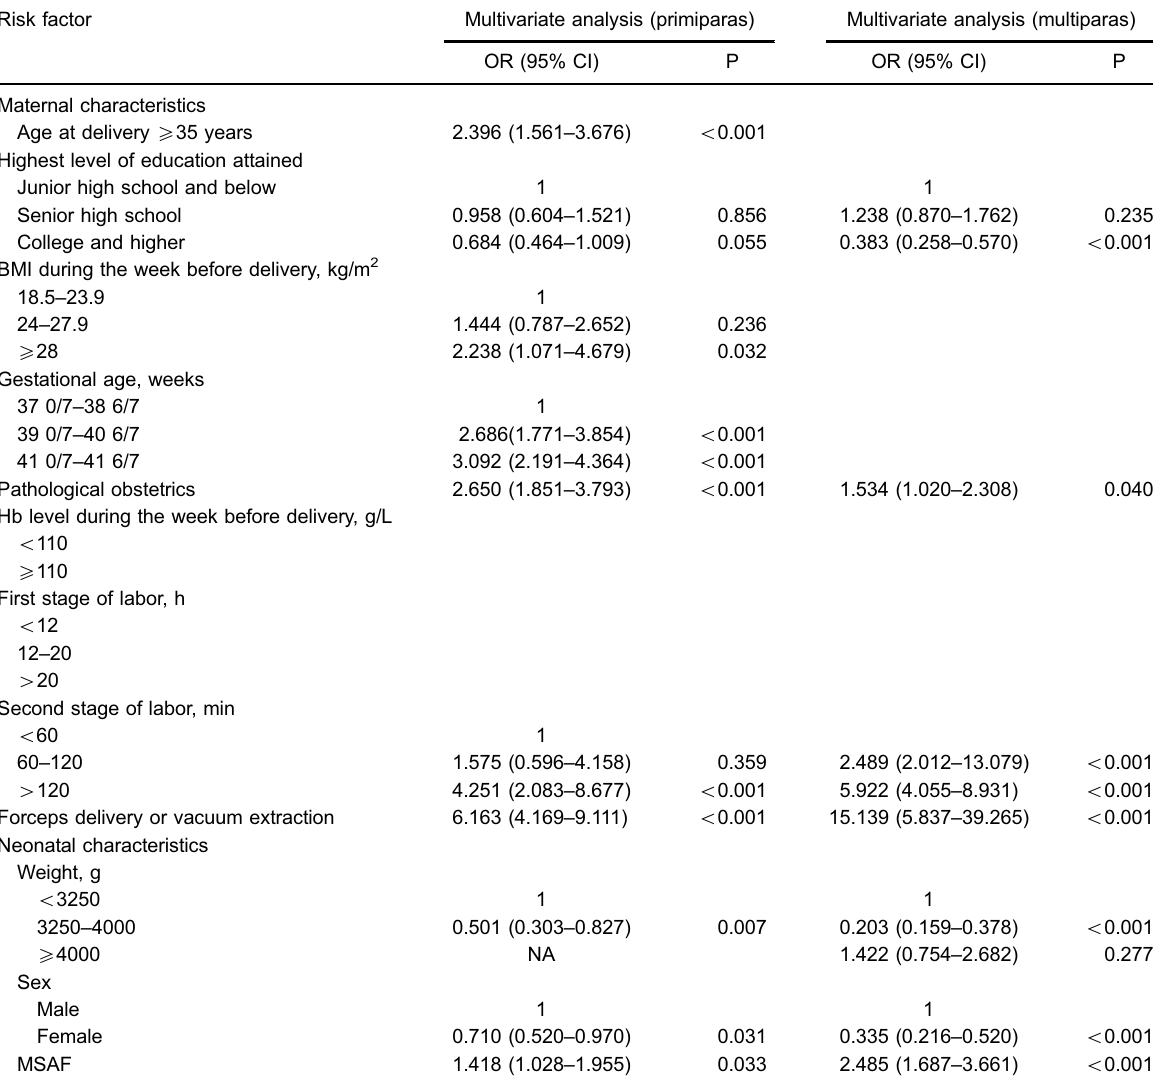
Table 4. Multivariate analyses of risk factors for low 1-min Apgar scores ( o 7) in the primiparous and multiparous